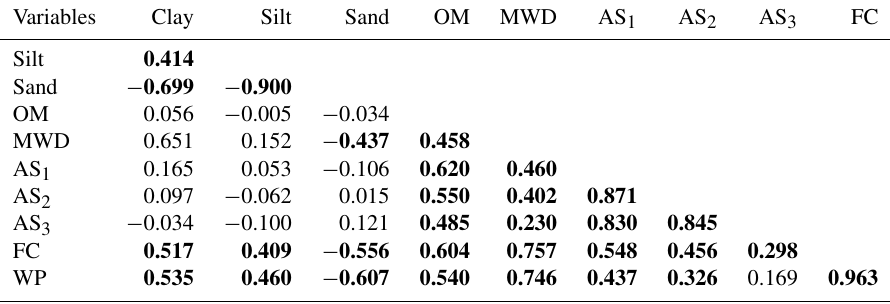
Table 4. Correlation coefficients between soil properties and fac- tors. F1 F2 Clay 0.545 0.447 Silt 0.388 0.553 Sand − 0.578 − 0.705 MWD 0.760 0.112 OM 0.612 − 0.325 AS 1 0.750 − 0.525 AS 2 0.654 − 0.603 AS 3 0.505 − 0.655 FC 0.923 0.149 WP 0.866 0.266 MWD, mean weight diameter; OM, organic matter content; AS 1 ,